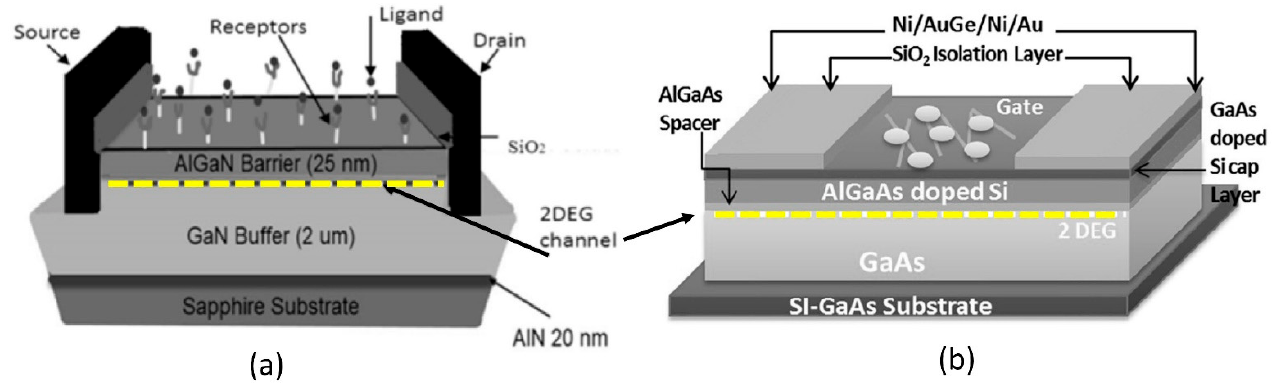
Figure 1. Schematic diagram of ( a ) AlGaN/GaN HEMT and ( b ) AlGaAs/GaAs HEMT with 2DEG (marked with dashed lines). Copyright 2021, with permission from Elsevier [38] and copyright 2021, with permission from Elsevier [49], respectively.